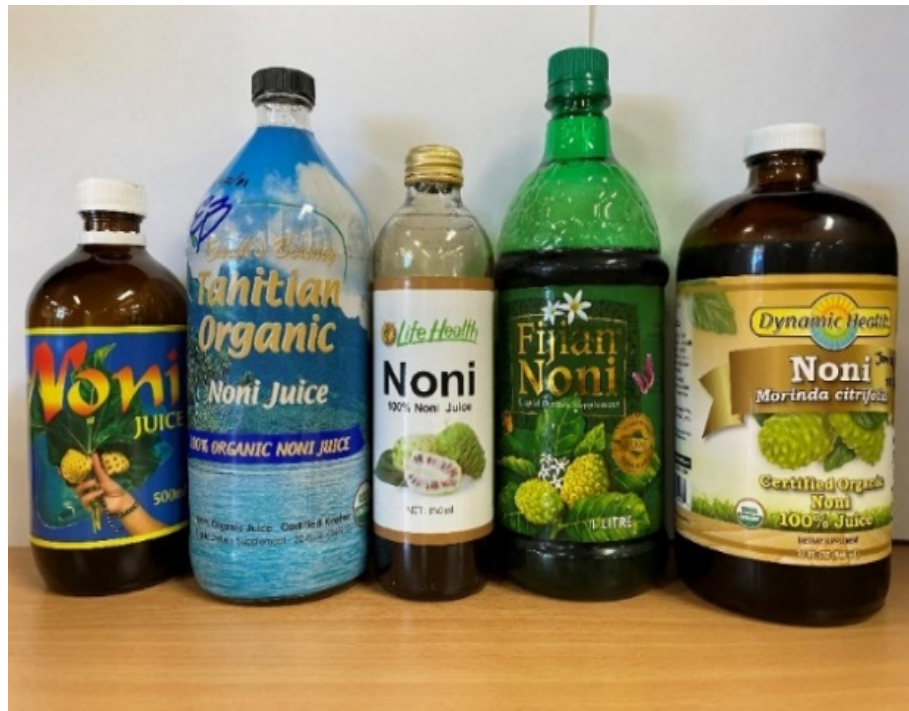
Figure 1. The five samples of commercial noni juice.